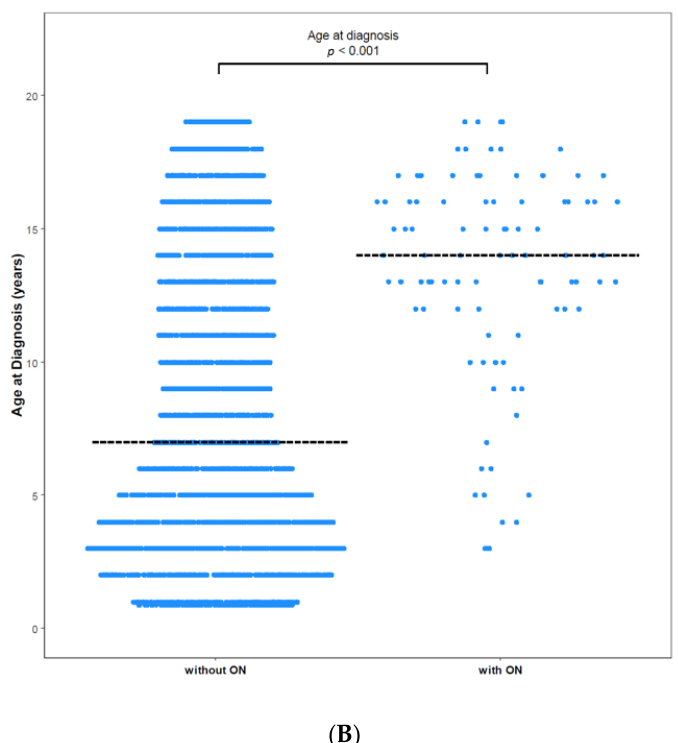
Figure 2. Age at diagnosis with and without ON among ( A ) total patients and ( B ) paediatric patients. ( A ) The mean age of patients without ON was 14.73 years, and that of patients with ON was 19.41 years ( p < 0.0001). ( B ) The mean age of paediatric patients without ON was 8.20 years, and that of paediatric patients with ON was 13.28 years ( p < 0.0001). Dashed horizontal lines reflect the median age at diagnosis of two groups.